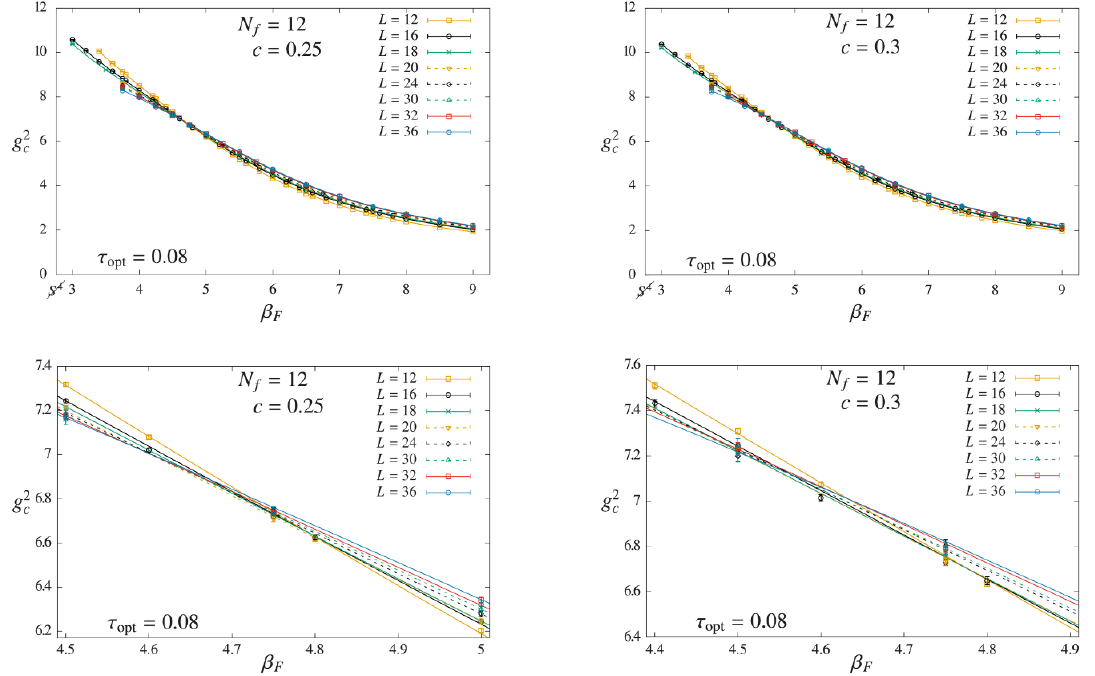
Figure 1 . Gradient (cid:13)ow renormalized coupling g 2 ( L ) vs. (cid:12) F for c = 0 : 25 (left) and c = 0 : 3 e c (right), both with optimal (cid:28) opt = 0 : 08. The lines are interpolations using the rational function form in eq. (4.1). The left edge of the plots in the top row indicates the boundary of the (cid:26)(cid:26) S 4 phase, (cid:12) ( c ) (cid:25) 2 : 75. The plots in the bottom row zoom in on the narrow regions around (cid:12) F . 5 where the F results from di(cid:11)erent lattice volumes all cross each other. For clarity we omit the uncertainties on the interpolations. Within uncertainties the crossings for L (cid:21) 16 and c = 0 : 3 are all